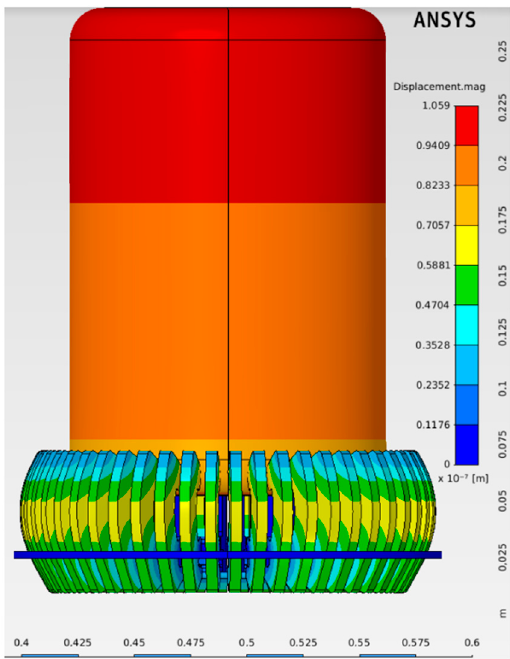
Figure 21. Deformation of small lamellas.